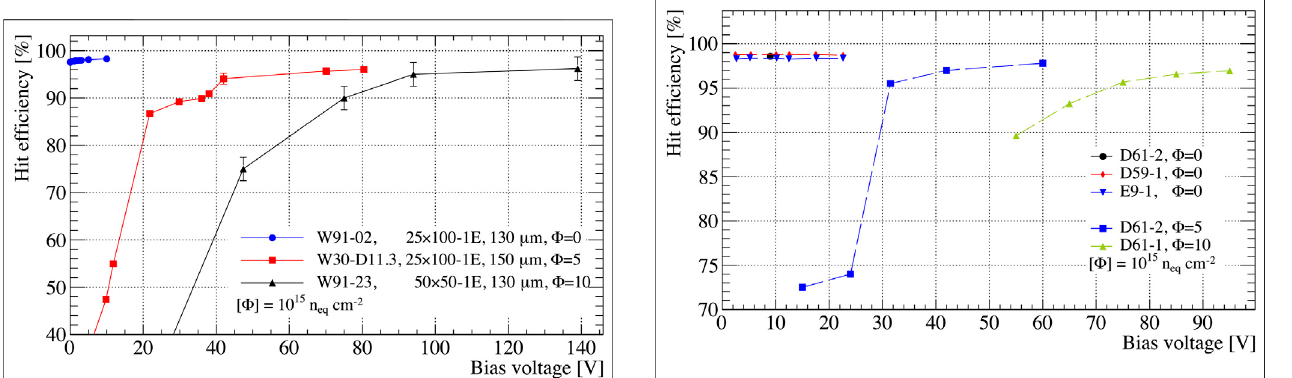
FIGURE 10 | Hit ef fi ciency as a function of the bias voltage for RD53A moduleswithFBK3Dsensorsfromsecondandthirdbatchesbeforeandafter irradiation. The modules are tuned to a mean threshold of 1 ke.